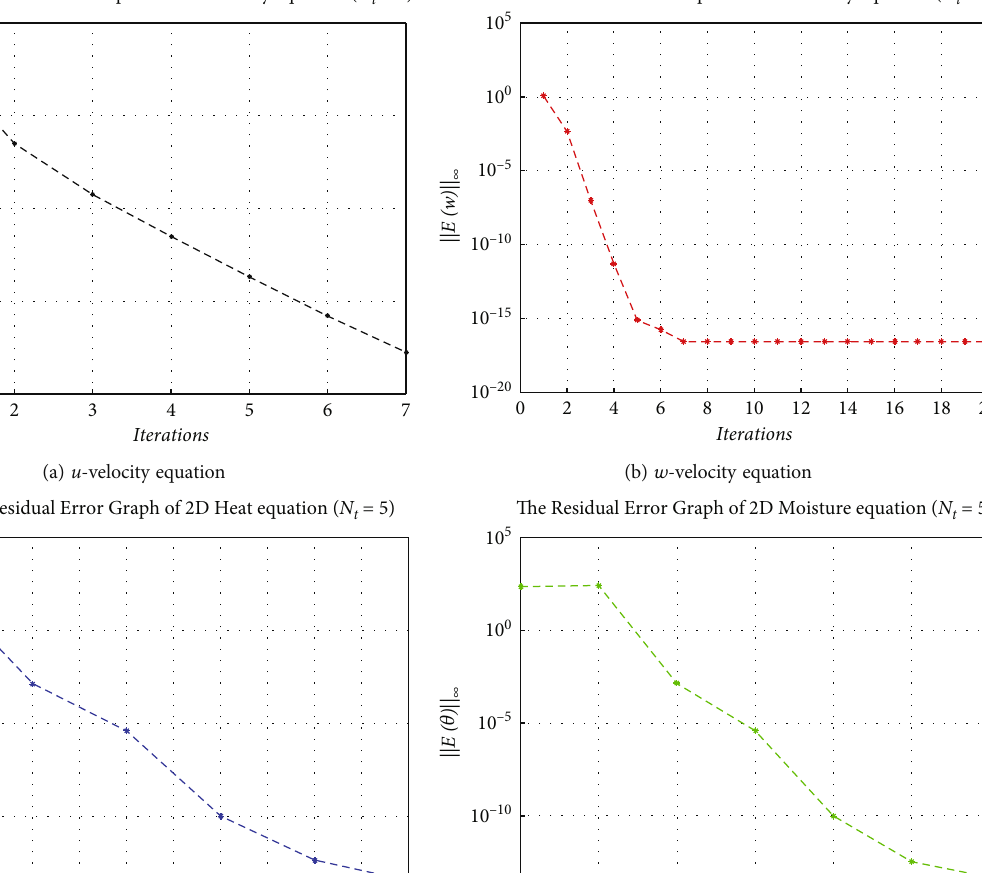
= N = 10 and N = 5 x z t